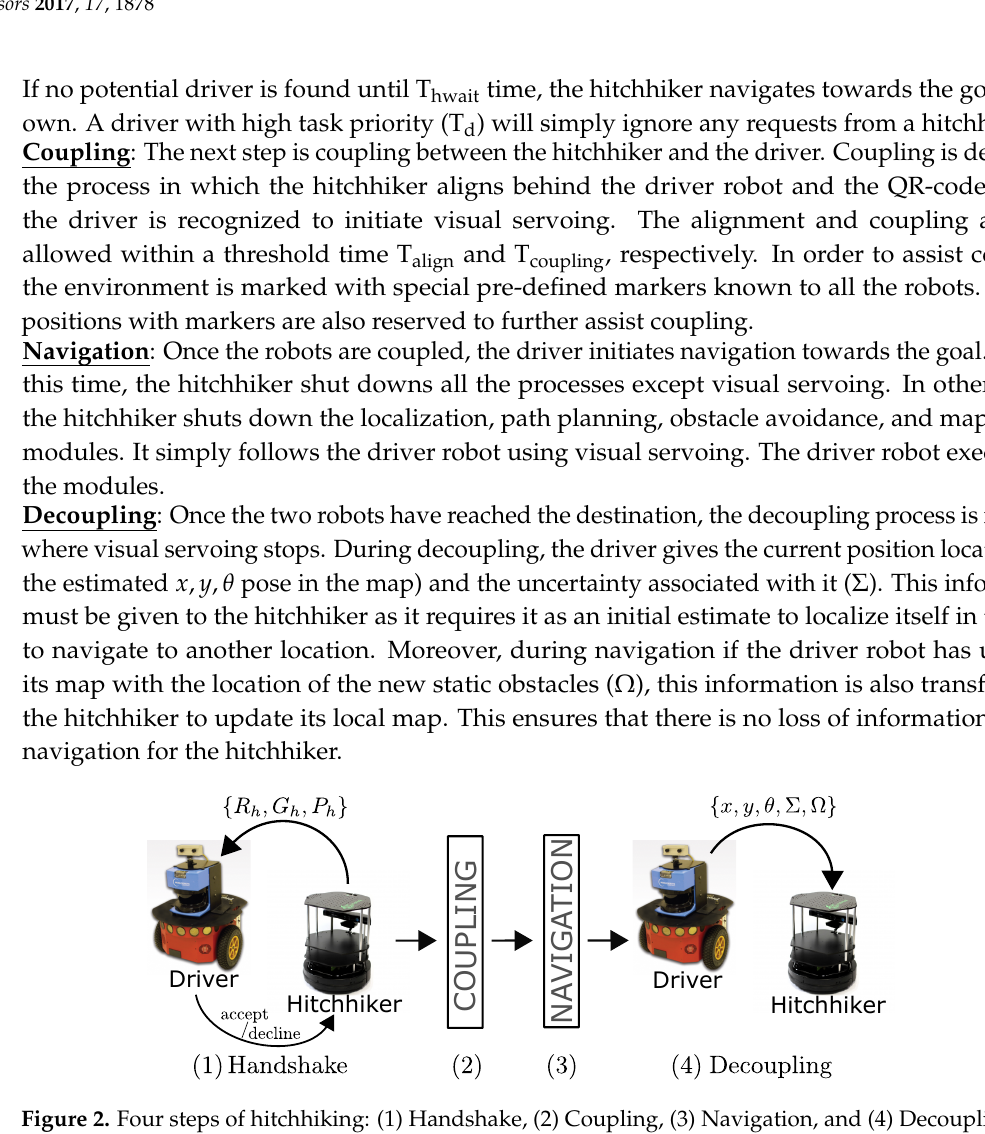
Figure 2. Four steps of hitchhiking: (1) Handshake, (2) Coupling, (3) Navigation, and (4) Decoupling.